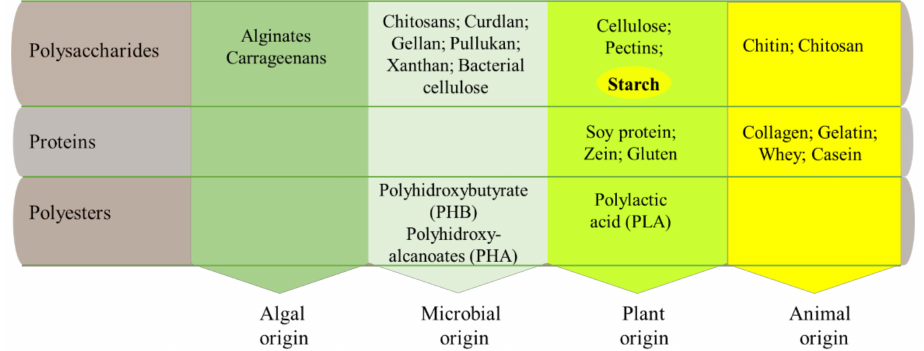
Figure 2. Classification of biopolymers depending on the general chemical composition and their origin (original drawing based on the literature research from